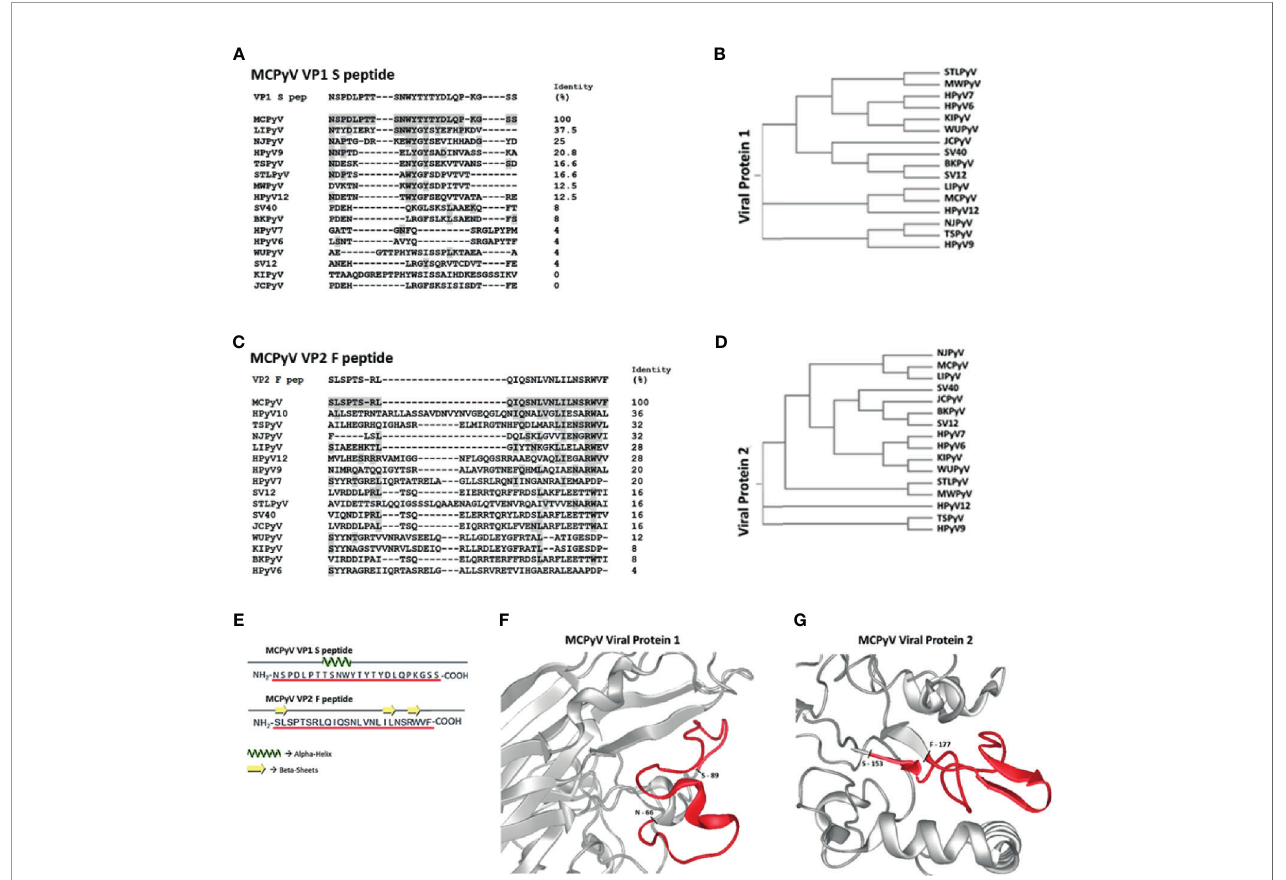
FIGURE 1 | Amino acid sequences of S/F peptides, polyomaviruses phylogenetic trees and partial VP1/2 structures visualizations. Panels (A, C) show identity between Merkel cell polyomavirus (MCPyV)-speci fi c VP1 S and VP2 F peptides and VP1 and VP2 from human/simian polyomaviruses (PyVs). Both S and F peptides were selected on the basis of their low homology with corresponding a.a. sequences from VP1 and VP2 from known human/simian PyVs. VP1 and VP2 a.a. sequences/IDs were obtained from (https://www.ncbi.nlm.nih.gov/protein/) and aligned with Clustal Omega software. Panels (B, D) show PyVs phylogenetic trees according to VP1 and VP2 from human/simian PyVs comparisons. Panel (E) : computational analyses indicate that both peptides show several random coiled domains with 1 alpha helix (S peptide) and 3 beta-sheets (F peptide). Panels (F, G) : partial view of S and F peptides (red) within the three-dimensional (3D) models of VP1 and VP2. The partial VP2 representation is based on a structural prediction obtained using DNASTAR